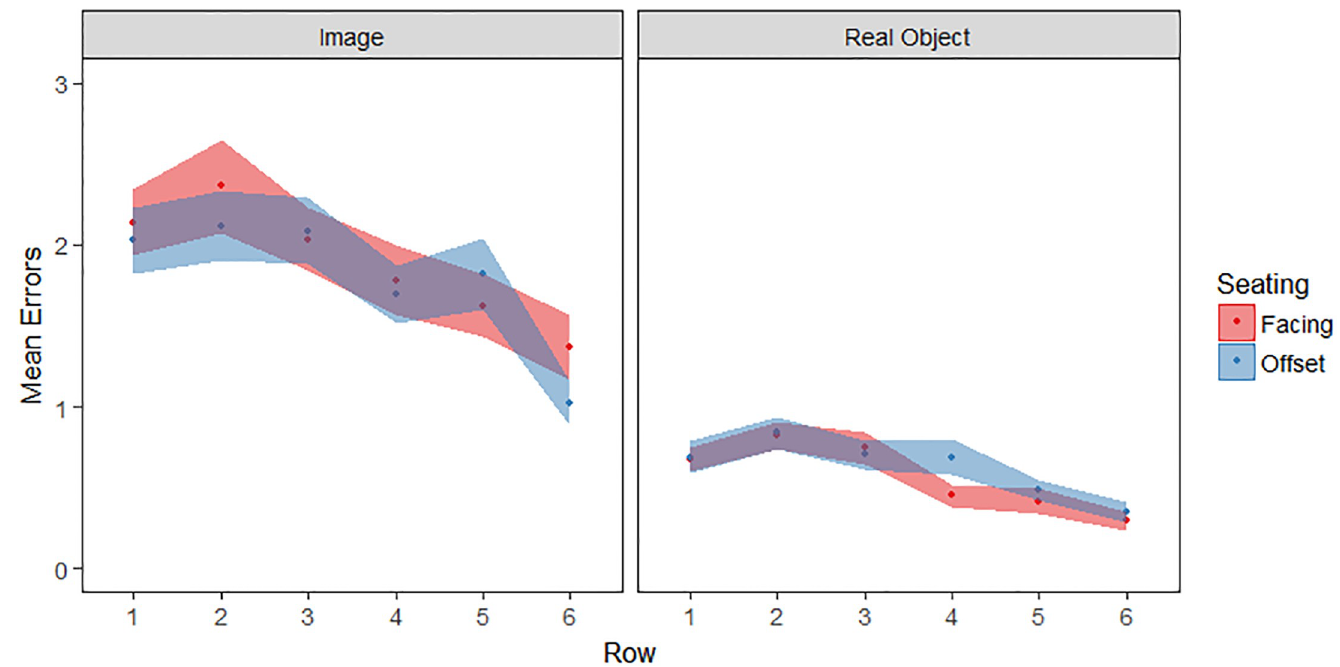
Fig 4. Location of errors ( M ± SE ).